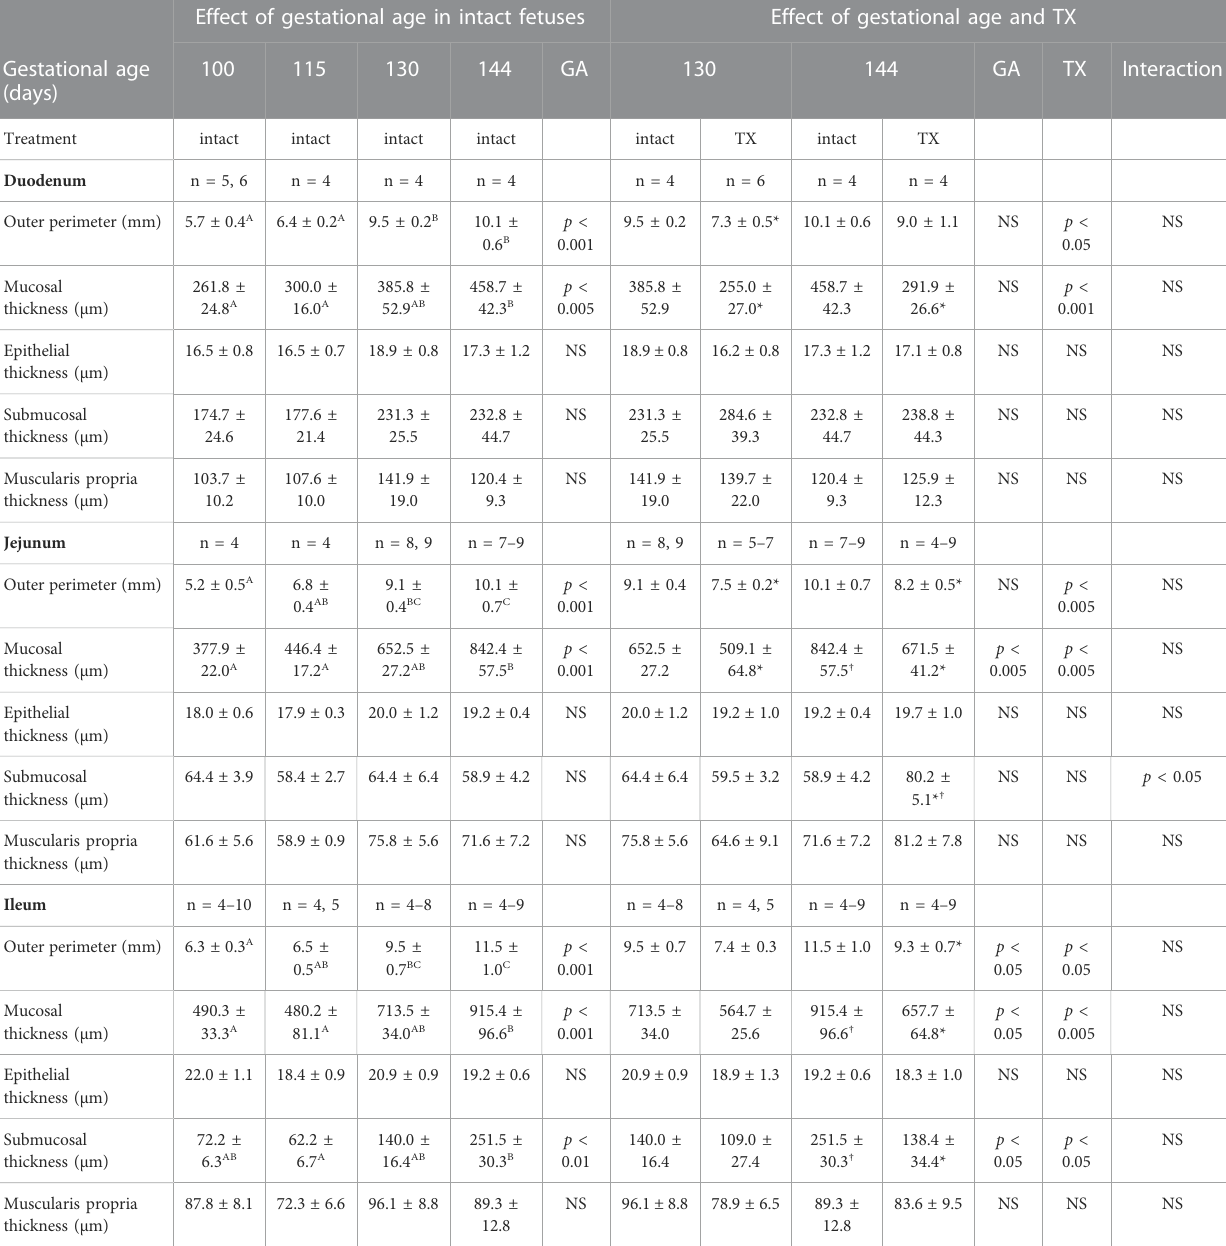
TABLE 1 Mean (±SEM) measurements of intestinal structure in the fetuses of each experimental group at tissue collection. One-way ANOVA assessed the effect of gestational age in the intact fetuses between 100 and 144 days of gestation: for each parameter measured, values with different superscript letters are signi fi cantlydifferentfromeachother( p < 0.05,Tukey ’ s posthoc test).Two-way-ANOVAexaminedtheeffectsofgestationalageandTXintheintactandTXfetuses studied at 130 and 144 days of gestation: *, signi fi cant difference from intact fetuses at the same gestational age ( p < 0.05, Tukey ’ s post hoc test); † , signi fi cant difference from fetuses of the same treatment at 130 days of gestation ( p < 0.05, Tukey ’ s post hoc test). GA, gestational age; TX, thyroidectomy; n, number of animals; NS, not signi fi cant. Effect of gestational age in intact